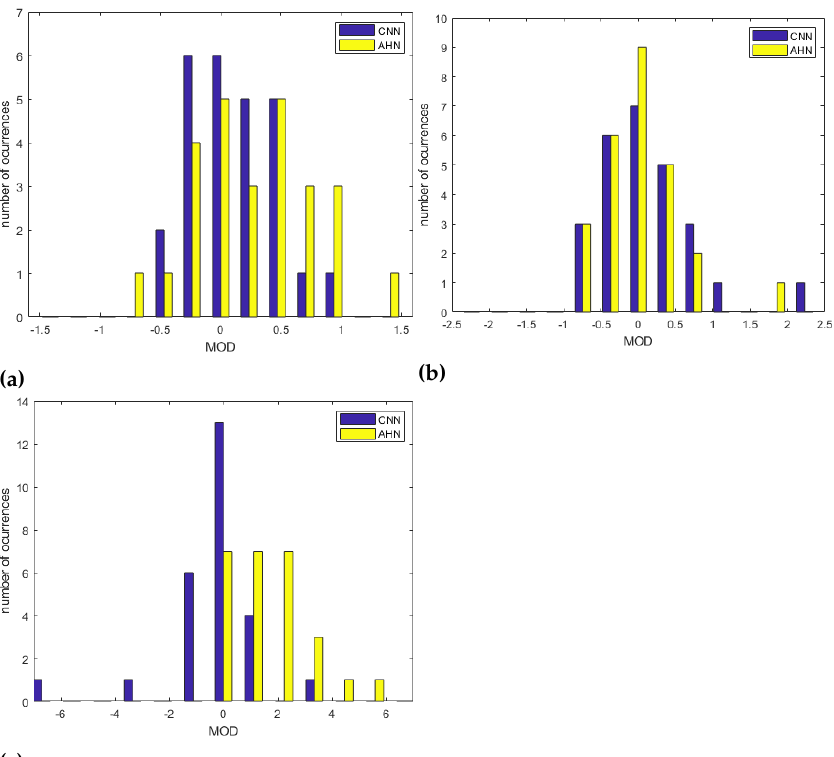
Figure 11. Overlapped histograms of MOD for AHN and CNN architecures for the strategies ( a ) MCV, ( b ) MV and ( c )